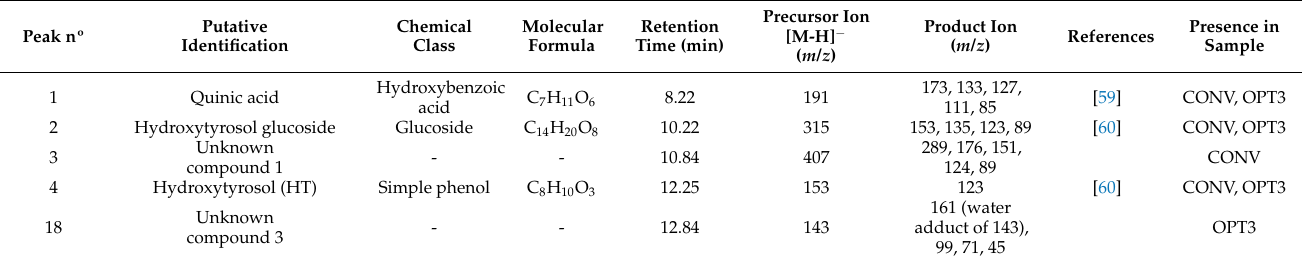
Figure 1. Scan chromatogram in electrospray ionization source in negative mode (ESI − ) for the conventional (CONV) ( A ) and the optimized (OPT3) ( B ) olive pomace (OP) dried extracts in aqueous solution. Table 4. Putative identification of phenolic compounds in the aqueous solution of conventional (CONV) and optimized (OPT3) dried extracts. The table includes the peak numbers as mentioned in the chromatogram (Figure 1A,B), together with the retention time, molecular formula, [M-H]- ion, major electrospray ionization source in negative mode (ESI − ) product ions for each compound, and the sample in which they